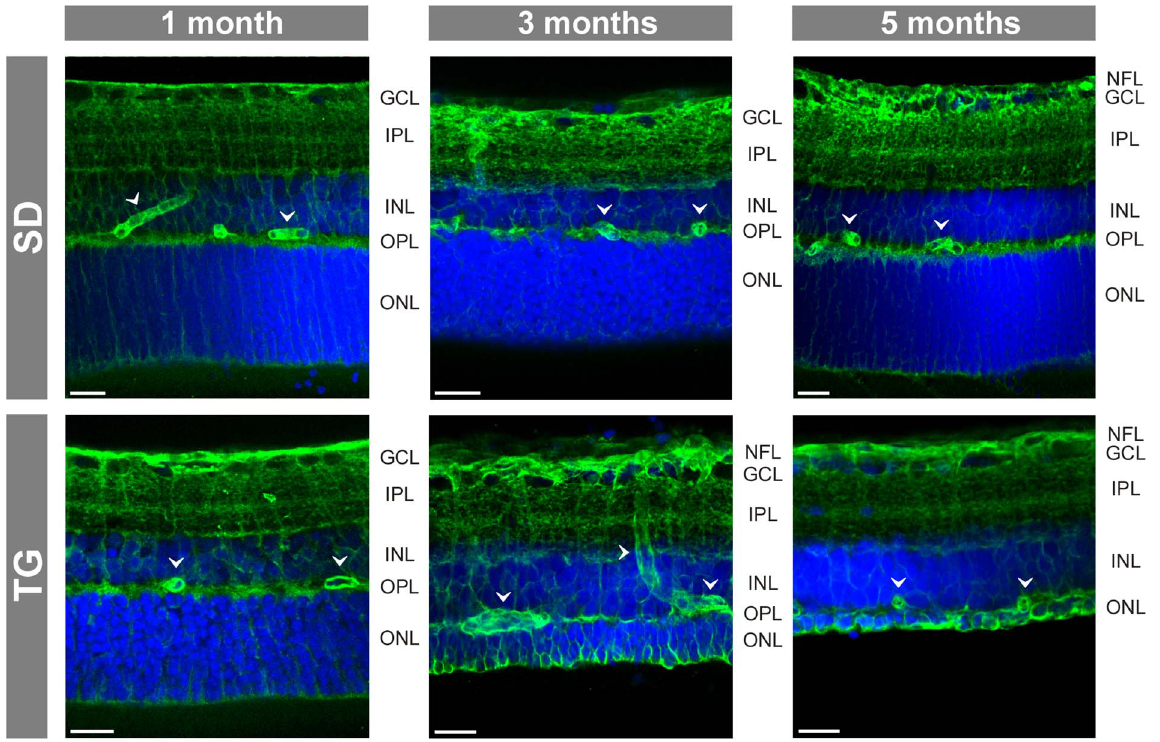
Figure 5. Age-dependent alterations in the immunolocalization of AQP4. Retinal slices obtained from control (SD; above ) and transgenic (TG) rats ( below ). Cell nuclei were labeled with Hoechst 33258 ( blue ). Arrowheads , perivascular labeling. GCL, ganglion cell layer; IPL, inner plexiform layer; INL, inner nuclear layer; NFL, nerve fiber layer; ONL, outer nuclear layer; OPL, outer plexiform layer. Bars, 20 m m.